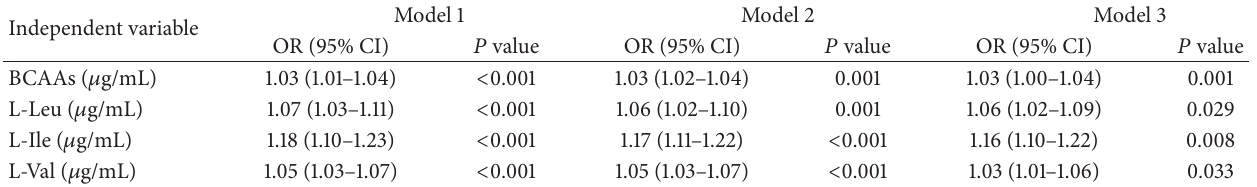
Table 4: Multiple logistic regression analyses of the relationship between BCAAs and high Framingham cardiovascular risk.